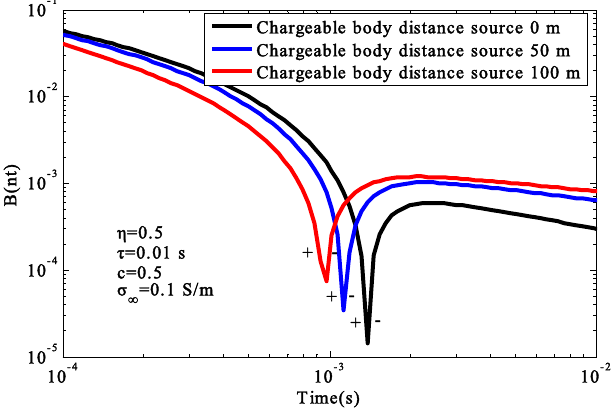
Figure 15. The influence of chargeable body depth on response curve. Appl. Sci. 2020 , 10 , 1027